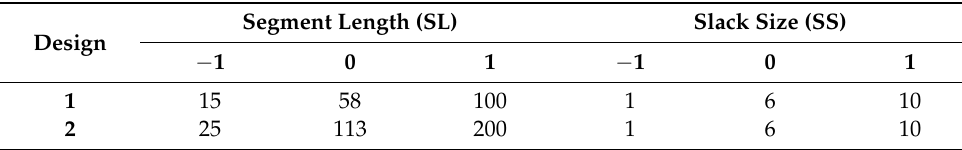
Table 4. SL and SS level values used in the full factorial